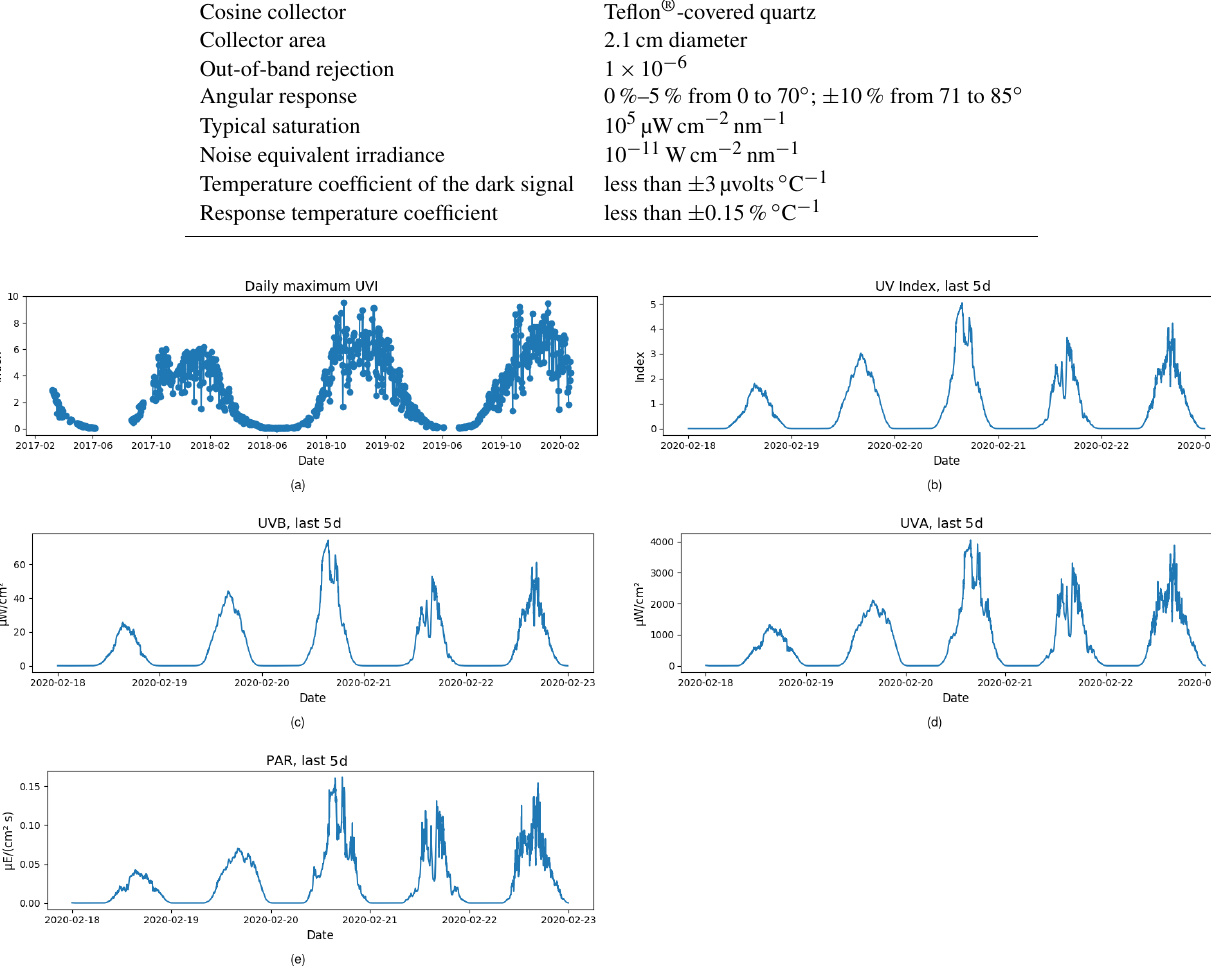
Figure 1. Near-real-time plots that were updated daily: (a) daily maximum UV index time series, (b) UV index, (c) UVB irradiance, (d) UVA irradiance and (e) PAR. Data in plots (b) – (e) are 1min